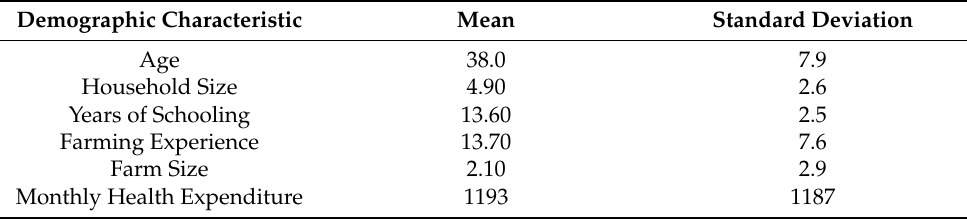
Table 1. Respondents Demographic Characteristics (N = 480).